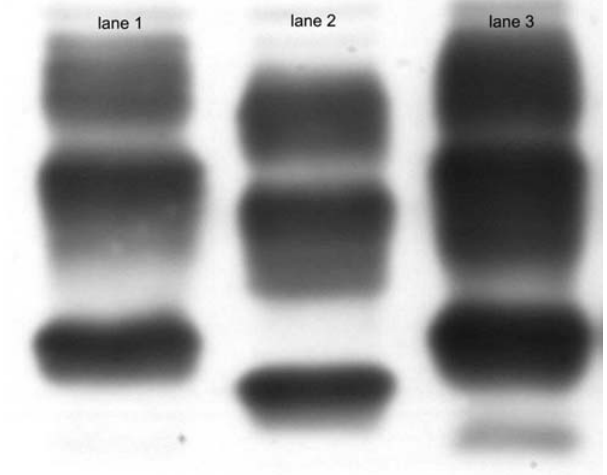
Figure 3. Western blot analysis of PrP after proteinase K digestion (lanes 1–3) using mAb 3F4. Lane1: PrP Sc type 1 from a sporadic CJD case. Lane 2 : PrP Sc type 2 from a sporadic CJD case. Lane 3 : Frontal cortex of patient D. As seen in lane 3 there is an additional band migrating at an apparent MW of 17 kDa.